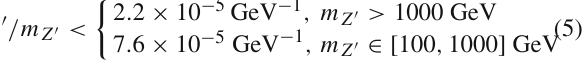
Fig. 2 Constraints of DM relic density, LEP, ILC-1 TeV and direct detection. The bands satisfy the DM relic density within the 2 σ range [29]. The colormap denotes the current annihilation cross sec- tion (cid:7) σv (cid:8) . The regions above the blue dashed-dotted, green dashed and cyan dotted curves can be excluded by 90% C.L. exclusion limit from PandaX-II [30], LEP data [31] and ILC-1 TeV, respectively